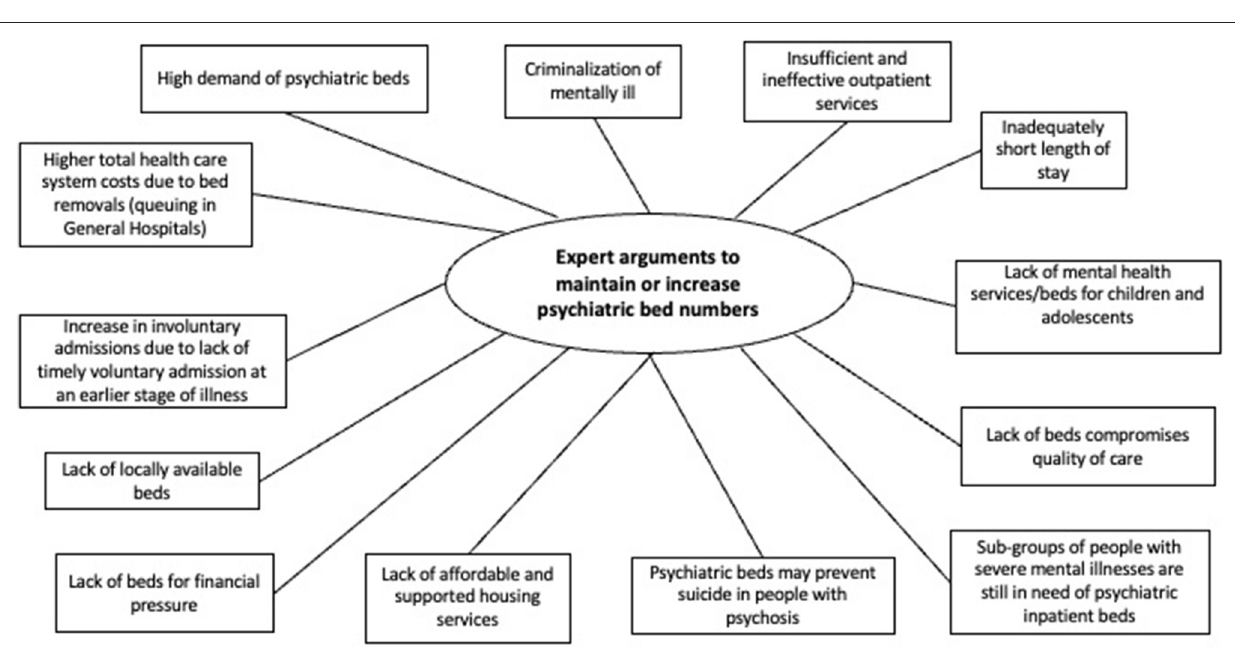
FIGURE 3 | Expert arguments to maintain or increase psychiatric bed numbers, a systematic review of qualitative